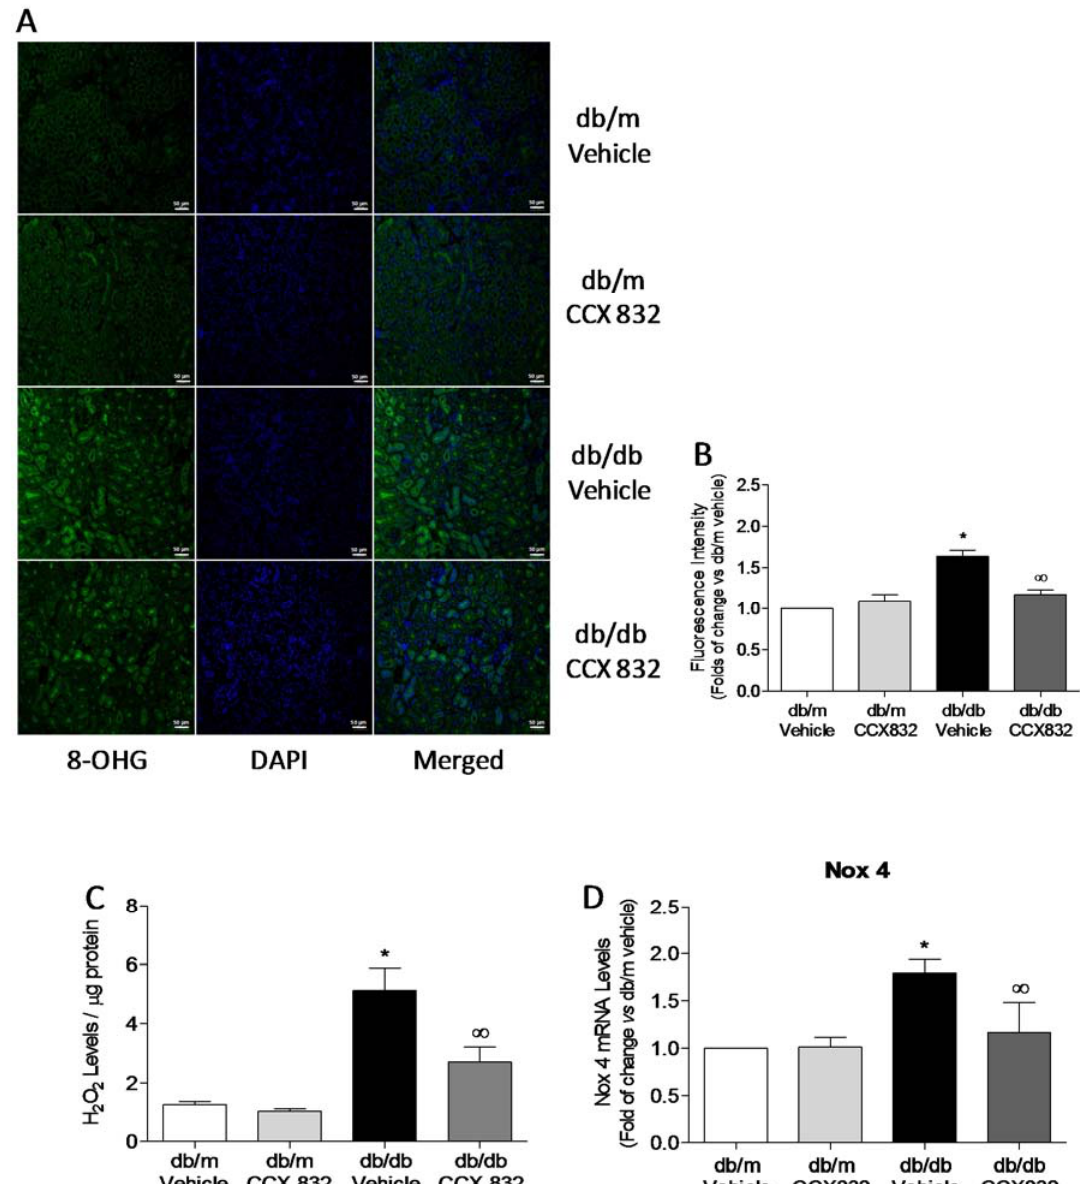
Figure 2. CCX832 reduces renal oxidative stress and Nox 4 expression in db/db mice. ( A ) Representative images and ( B ) quantitative analysis of 8-hydroxyguanosine (8-OHG)-positive nuclei in kidneys from vehicle or CCX832-treated db/m and db/db mice. Scale bar = 50 µ m; 20X. ( C ) Renal H 2 O 2 levels were measured by Amplex red assay. Amplex red values were normalized by protein content. ( D ) Gene expression of Nox 4 in kidneys was determined by real time PCR. The values were normalized by glyceraldehyde-3-phosphate dehydrogenase (GAPDH) gene expression. Results represent the mean ± SEM of 5 to 6 experiments. * p < 0.05 vs. db/m, ∞ p < 0.05 vs. db/db vehicle .